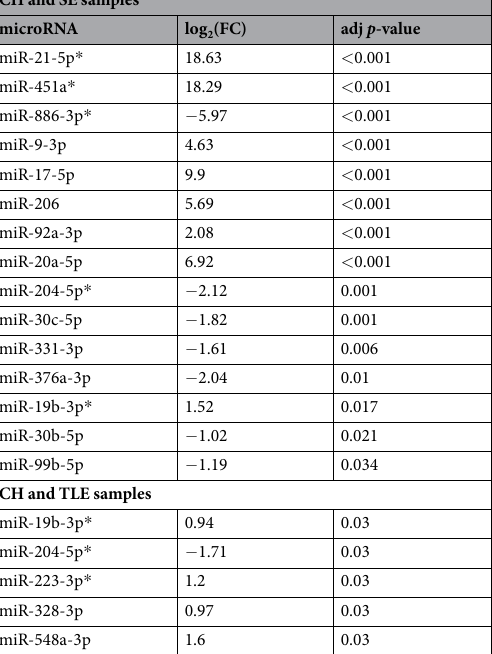
Table 2. microRNA differentially expressed in profiling between patient groups and controls. Key: CH, control headache; SE, status epilepticus; TLE, temporal lobe epilepsy. log 2 (FC) and adjusted p -value for significantly differential expressed microRNA (OpenArray). * MicroRNA selected for